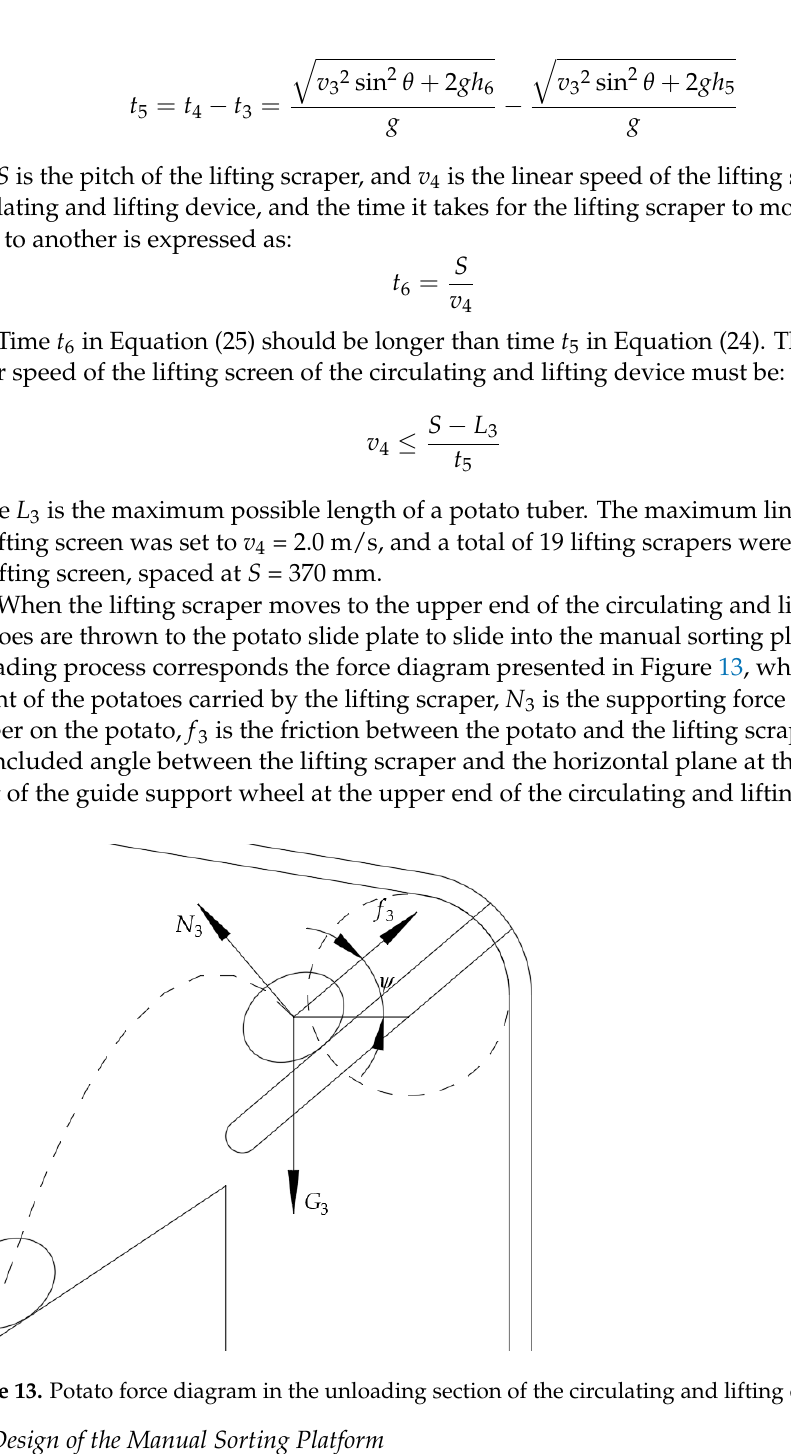
Figure 14. Diagram of the manual sorting platform: 1—driving wheel; 2—supporting wheel; 3— height-adjusting rod sleeve; 4—height-adjusting rod; 5—connecting frame; 6—conveyor screen; 7— side plate; 8—guiding wheel. 4. Field Test Method and Test Results In October 2021, fi eld tests of the self-propelled machine for combined potato har- vesting and residual plastic fi lm retrieval were conducted in Xiangquan town, Dingxi city, Gansu Province. The speci fi c conditions of the test were adopted in accordance with in- dustry standard GB/T5262-2008 [50]. The test fi eld was planted in large ridges with two